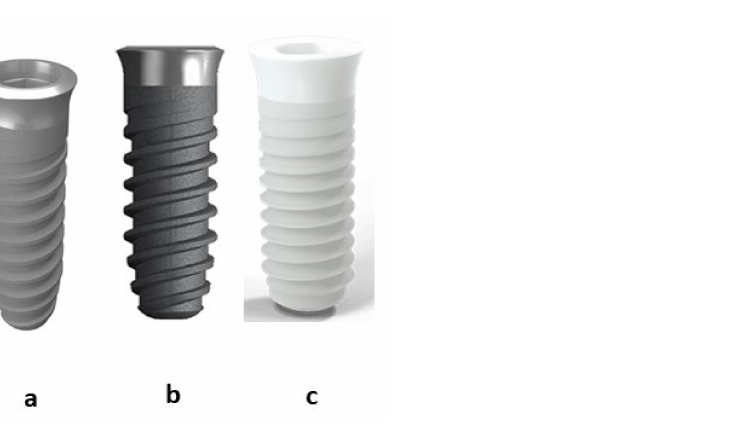
Figure 1. Dental implants used in this study. ( a ) Titanium passivated (Ti). ( b ) Titanium rough and passivated (Ti R). ( c ) Zircona-YZP (ZrO 2